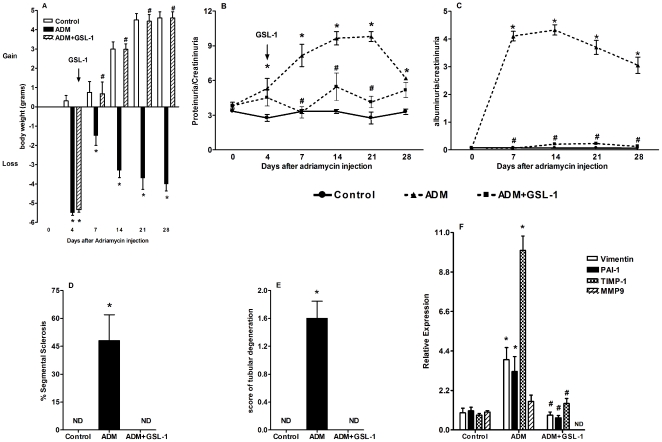
GSL-1 treatment reversed the time-dependent ADM-induced renal failure.BALB/c mice were injected at day 0 with 10 mg/kg of adriamycin (ADM) or treated with ADM and four days later with 5 µg/mouse GSL-1 (ADM+GSL-1). (A) The loss of body weight associated with ADM injection was reversed after GSL-1 treatment. The time-dependent renal failure, characterized by increases in the proteinuria (B) and albuminuria (C) ratios, was inhibited after GSL-1 treatment at day 4 post-ADM injection. This amelioration in renal function was associated with kidney preservation (D and E) and the inhibition of transcripts for fibrogenic proteins (F). * p<0.05 vs. control; # p<0.05 vs. ADM.